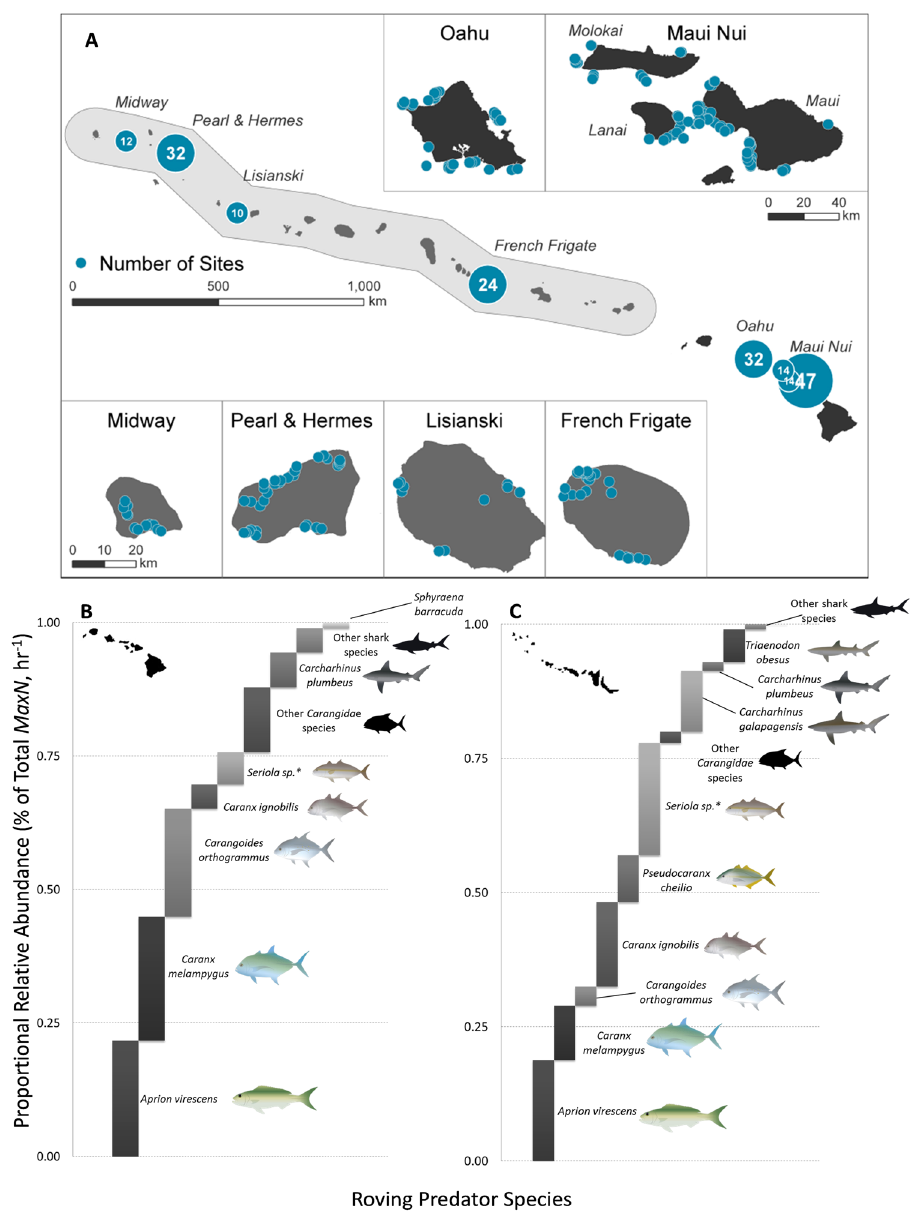
Figure 1. ( A ) Map indicating BRUVS sampling locations across the Hawaiian Archipelago. Map generated in ArcGIS, 10.3 (http://www.esri.com/software/arcgis) by Tomoko Acoba (NOAA PIFSC CREP). ( B ) Proportional relative abundance (% of total MaxN , hr − 1 ) of total predator assemblages in the MHI and ( C ) NWHI. * Indicates numerical abundance of Seriola dumerili , Seriola rivoliana , and Seriola sp . (excluding Seriola lalandi ) pooled. Staggered bar plots generated in MS Excel 2010 (https://products.office.com/en-us/microsoft-excel-2010). Maps in the figure were generated using Adobe Illustrator CS5